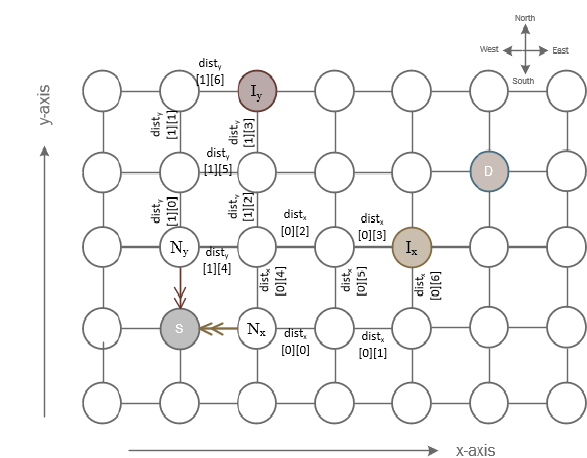
Fig. 3. Remote distant links represent congestion information